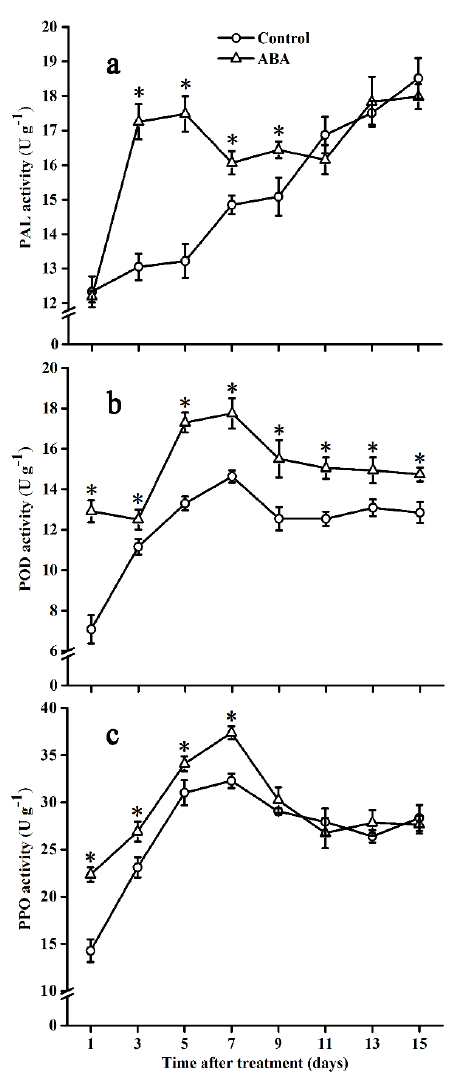
Figure 5. Effect of ABA on PAL ( a ), POD ( b ), and PPO ( c ) activities in the tomato during storage at 20 °C. Vertical bars represent the standard deviation (SD, n = 3). Asterisks (*) represent significant differences ( p < 0.05) between the ABA and control treatments.